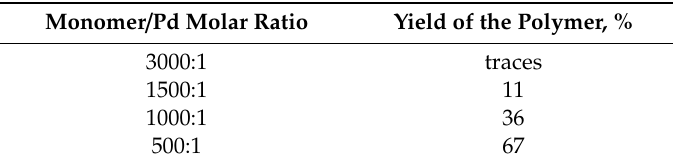
Table 1. Addition polymerization of 3-pentafluorophenyltricyclononene-7 (the catalyst was Pd(OAc) 2 /PCy 3 /NaBARF, the Pd(OAc) 2 /PCy 3 /NaBARF molar ratio was 1:2:5, [monomer] = 0.7 M, 14 days, the solvent was chloroform, T = 30 °C).